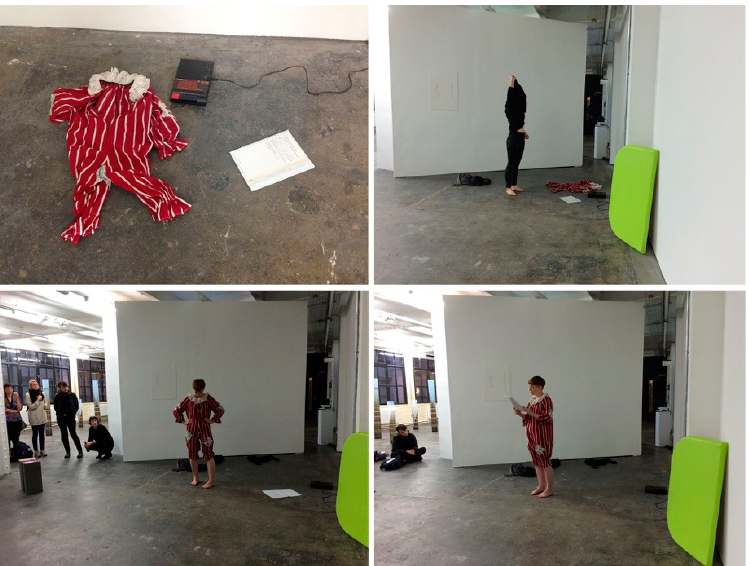
Figure 1. Denton, Grace. Sixty Five , performance with tape player, clown suit, and BA dissertation Part of There Were Islands BxNU MFA performance event, BALTIC 39. June 2016. Images courtesy Craig Pollard.